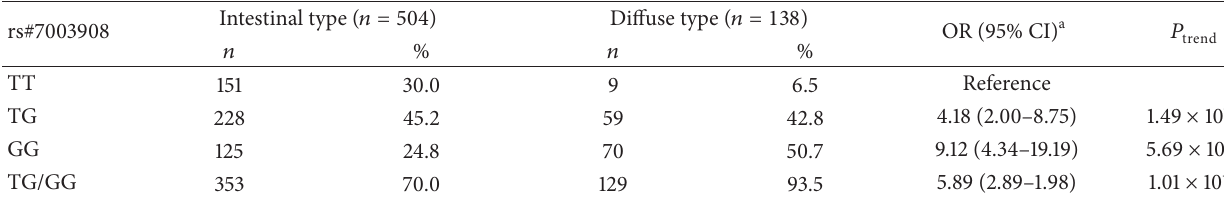
Table 6: XRCC7 rs#7003908 polymorphism and Lauren’s